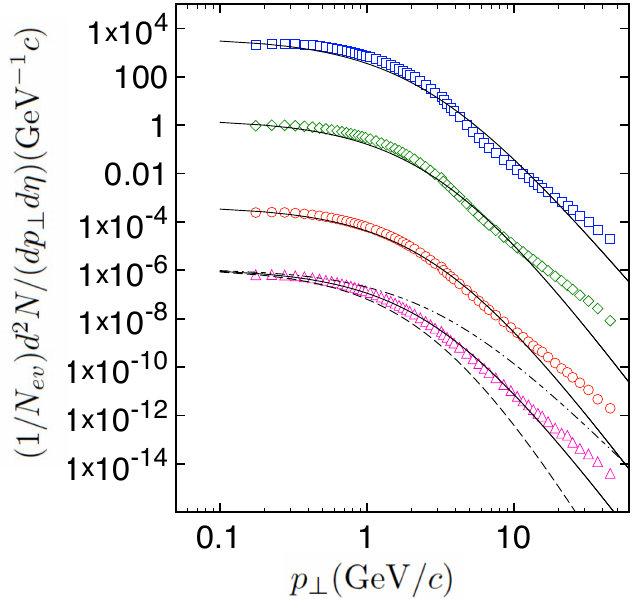
Import √ s NN = 5.02 TeV Pb-Pb Figure 7. Transverse momentum distributions of produced charged hadrons in collisions calculated from Hagedorn’s formula (see text) compared with ALICE data [43] for 0–5%, 20–30% ( × 10 − 3 ), 50–60% ( × 10 − 6 ) and 70–80% ( × 10 − 8 ) centralities (top to bottom). The dot-dashed curve has power index n = 6.2, the dashed curve n = 10.2, solid curves are for n = 8.2. Error bars are smaller than the symbol